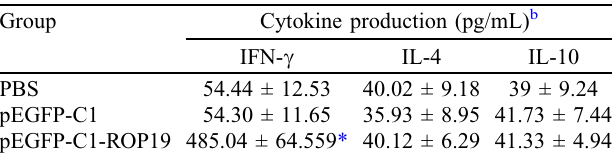
pEGFP-C1-ROP19 485.04 ± 64.559* 40.12 ± 6.29 41.33 ± 4.94 a Splenocytes from four mice per group two weeks after the final immunization. b Values for IFN- c at 96 h, IL-4 at 24 h, and IL-10 at 72 h are expressed as mean ± SD. * Compared with PBS or pEGFP-C1 group, p < 0.05.